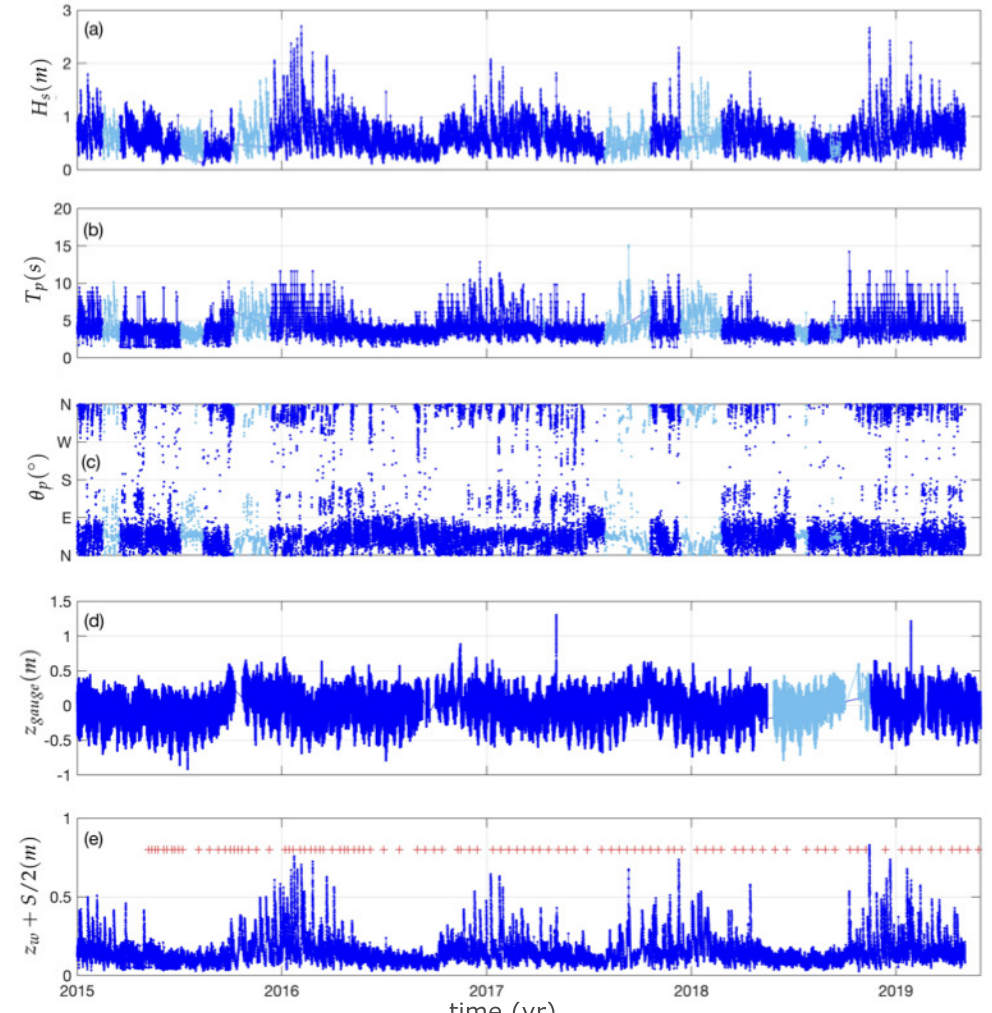
Figure 2. Significant wave height ( a ), peak period ( b ), wave direction ( c ), water level measured inside the port ( d ), and run up two percent ( e ). Red marks indicate the topographic measurement dates. The data in dark blue correspond to measurements. The data in light blue correspond to Wave Watch III and a tide gauge located 40 km east of